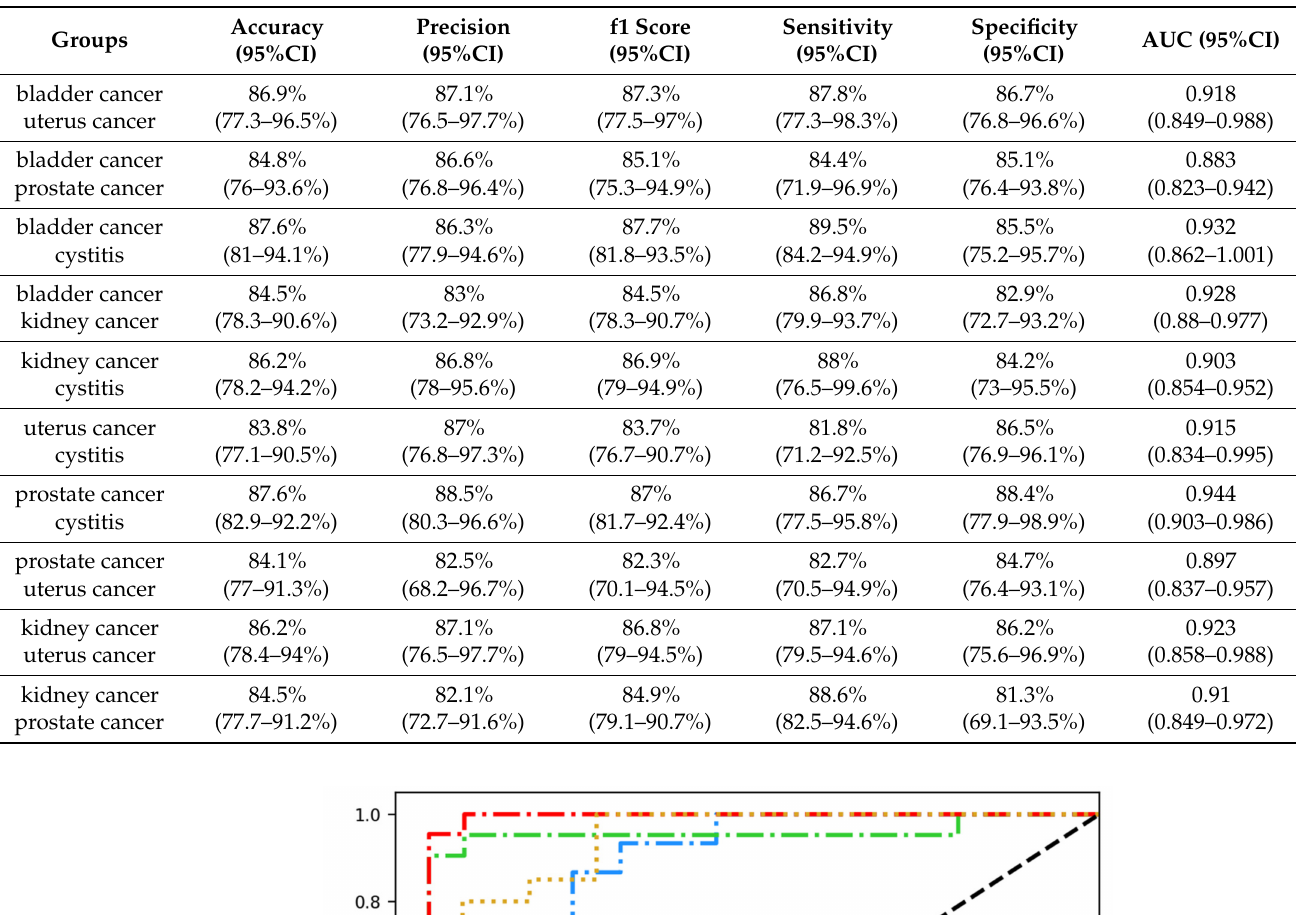
Table 7. Predictive performance of the lightGBM model.